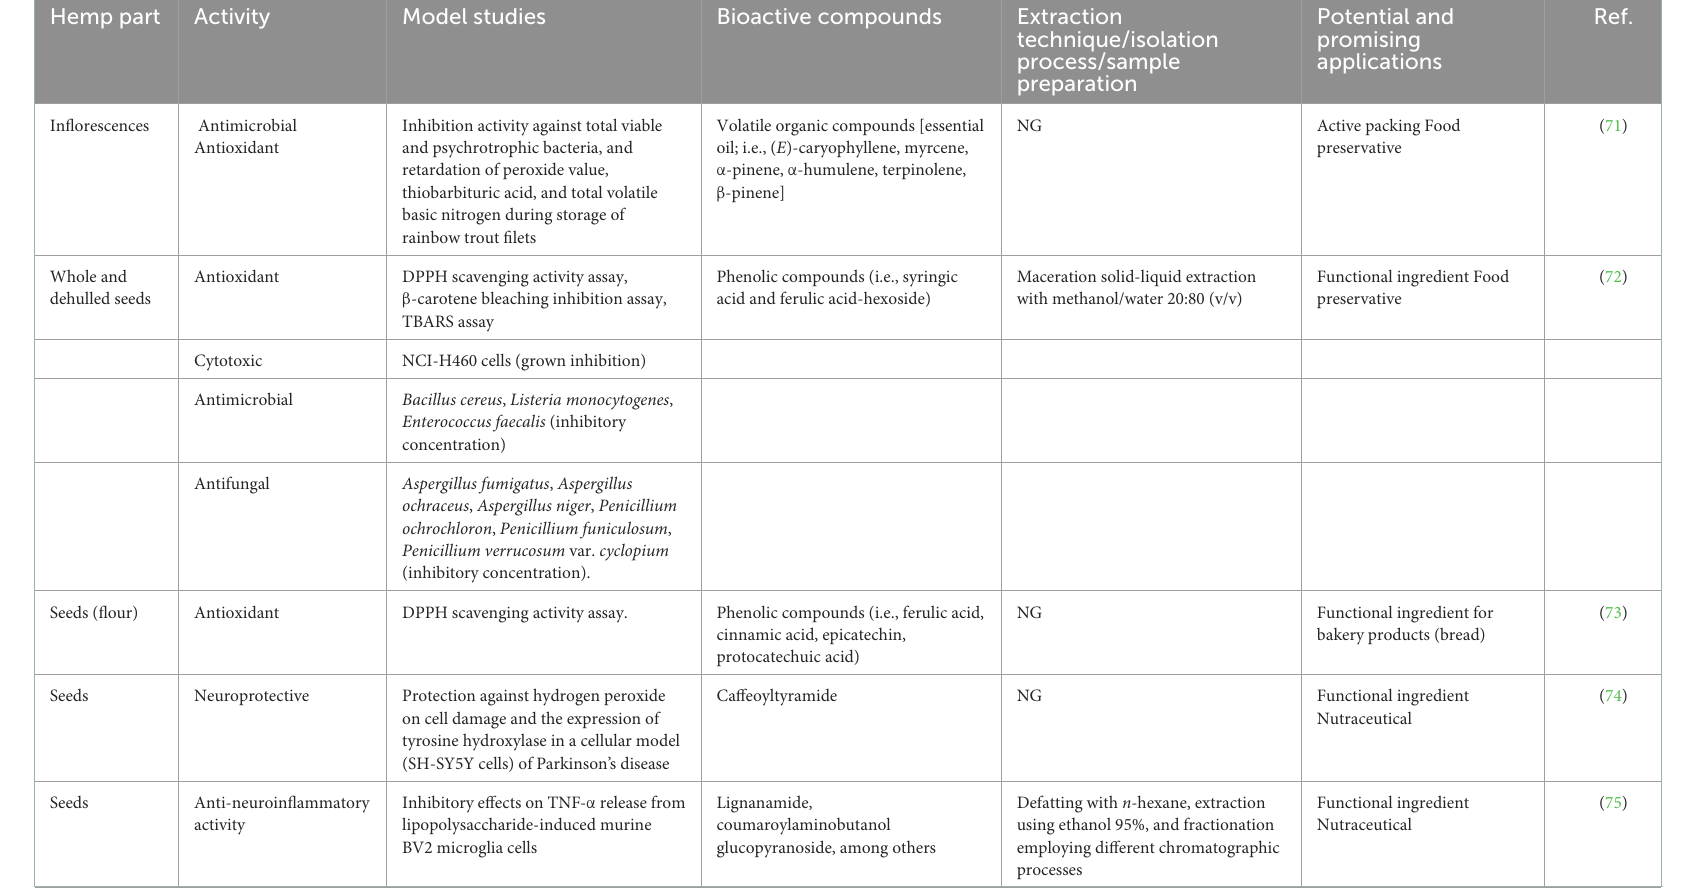
TABLE 2 Bioactivities found for compounds in hemp